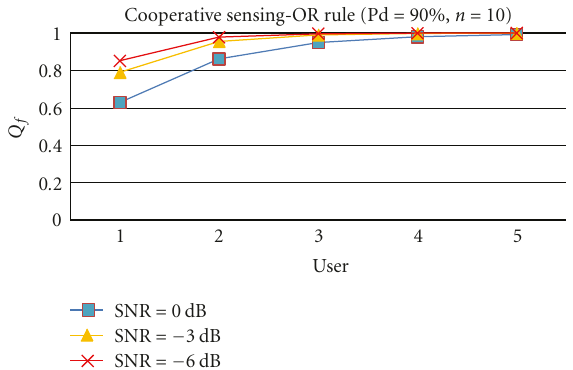
Figure 8: Performance of probability of false alarm using OR-rule cooperative sensing under various SNR conditions.